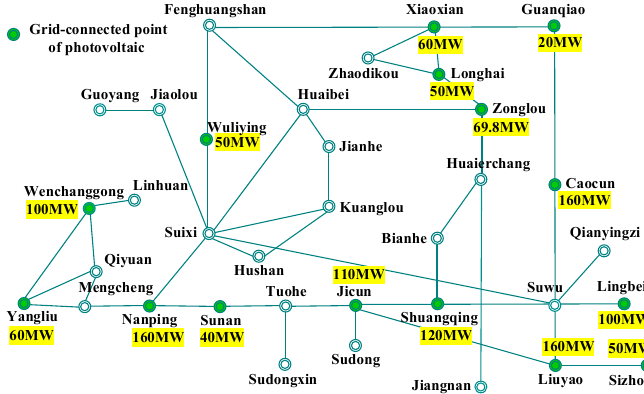
Figure 16. Single line diagram of Huaisu 220 kV power grid.